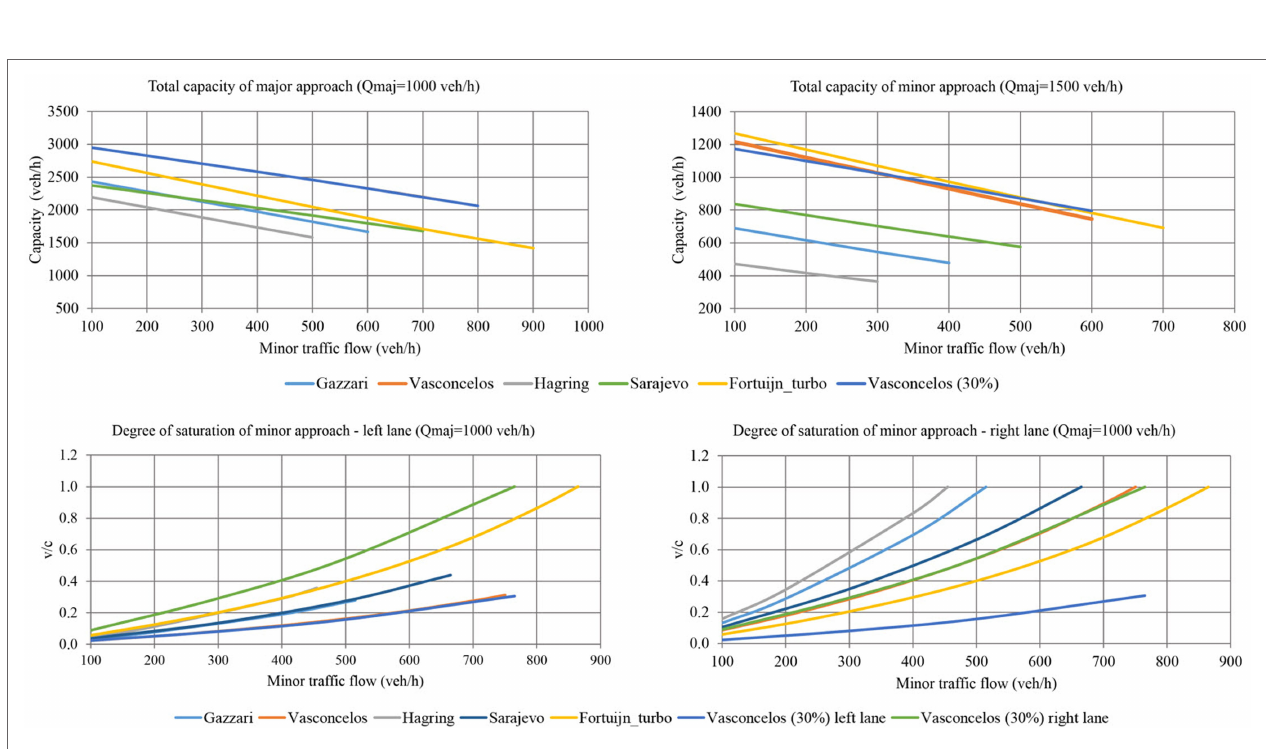
FIGURE 7 | Capacity and v / c curves for scenario A 7